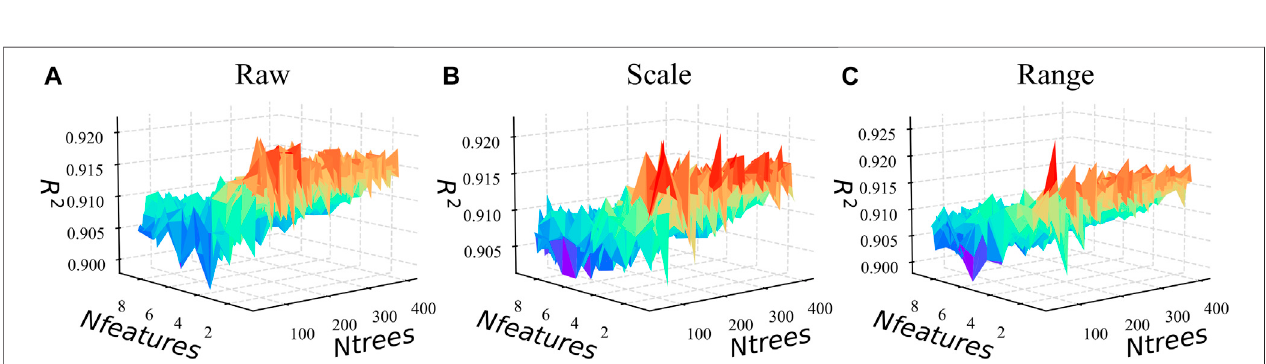
FIGURE 5 | Grid search results of RF under different preprocess methods. (A) is Raw , (B) is Scale , (C) is Range .